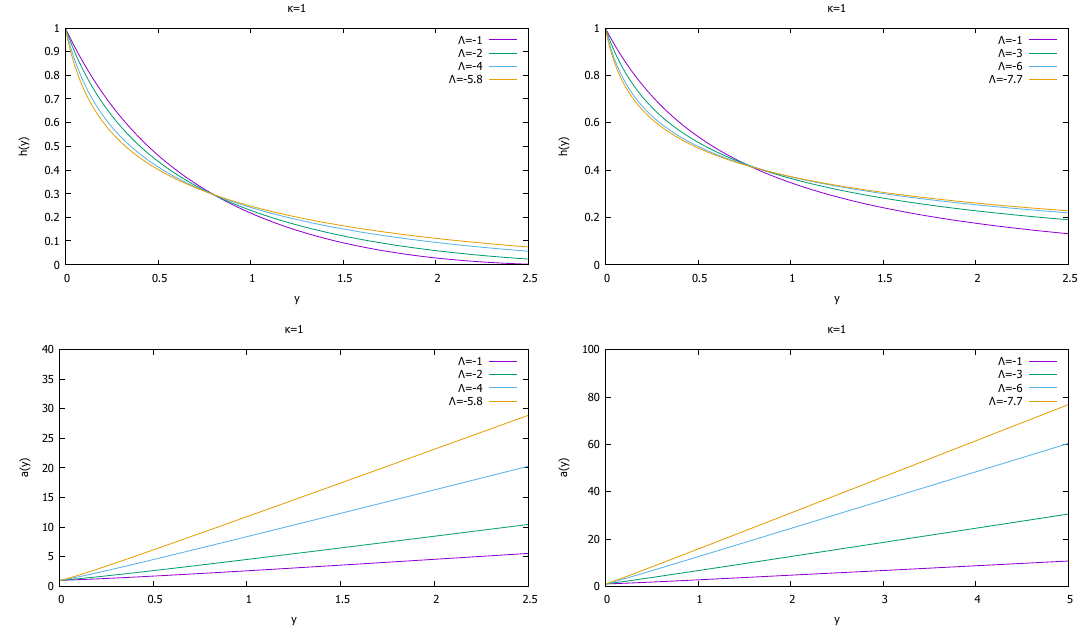
Figure 7 . Pro(cid:12)le function h (upper) and metric function a (lower) of charge one BPS baby 2 Skyrmions for (left) and 2 (right) with (cid:20) = 1 and for di(cid:11)erent (cid:25) U (cid:25) U